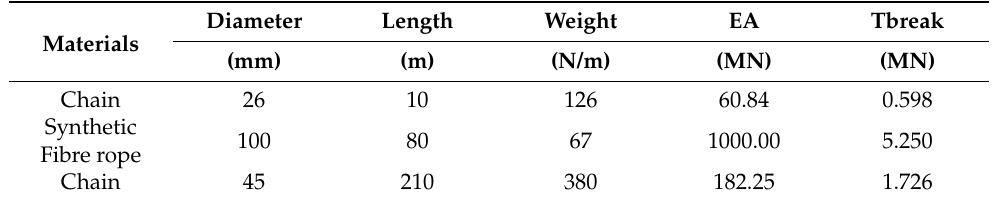
Table 6. Material property of cables for Case 2 (second Table 4. Material property of cables for Case 1.